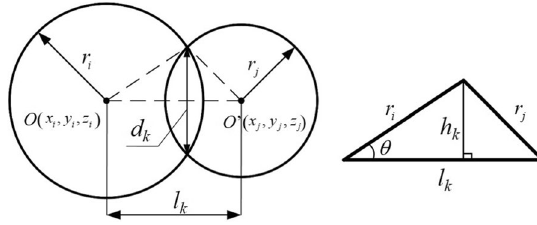
Figure 6 Calculation diagram of particle contact